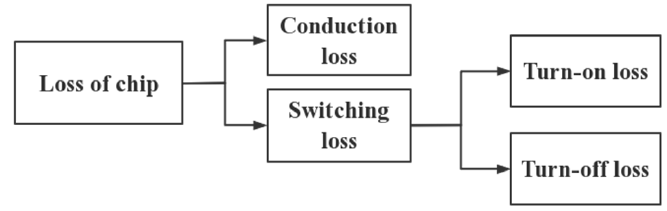
Figure 2. Composition of IGBT module loss.